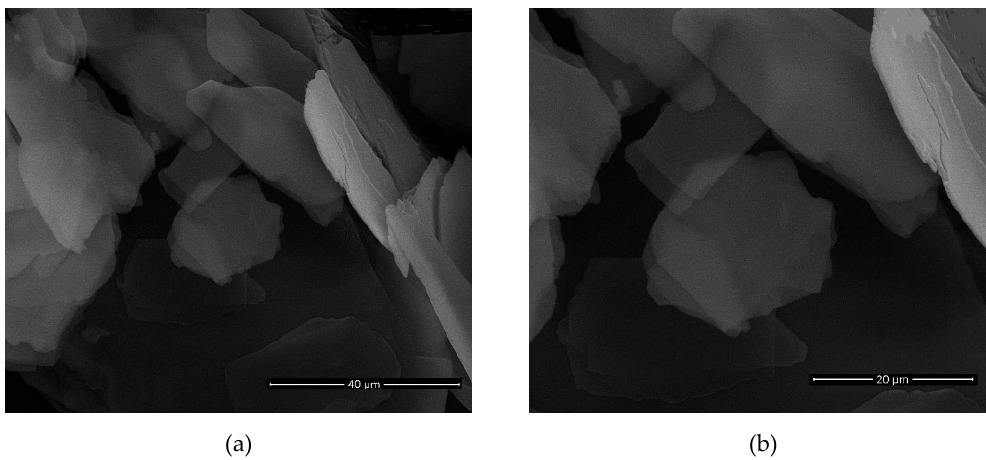
Figure 9. SEM images of the M x2c3 sample with a sonication time of 9 h with higher magnification ( a ) 500×; ( b ) 1000×.